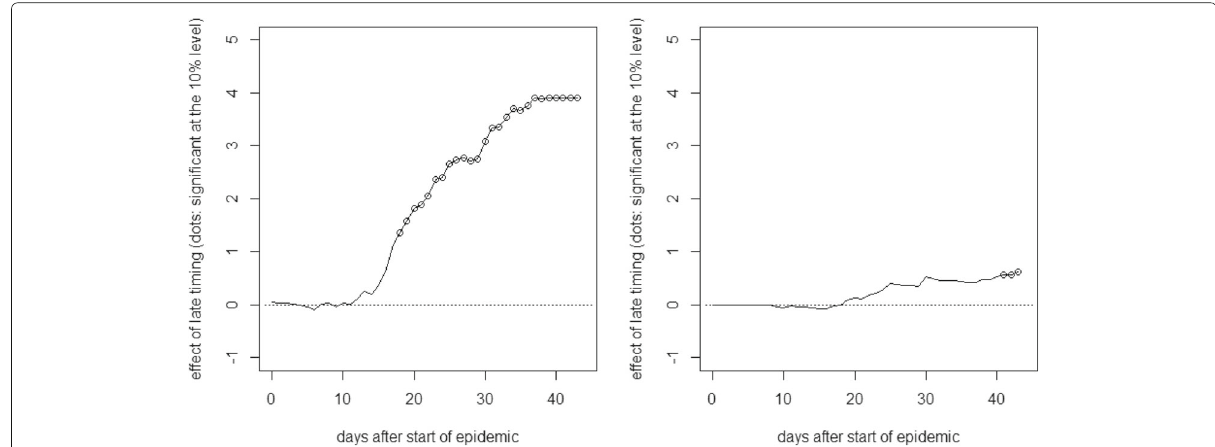
Fig. 10 Effect of late timing of measures on cumulative hospitalizations (left) and deaths (right) per 10,000 inhabitants in